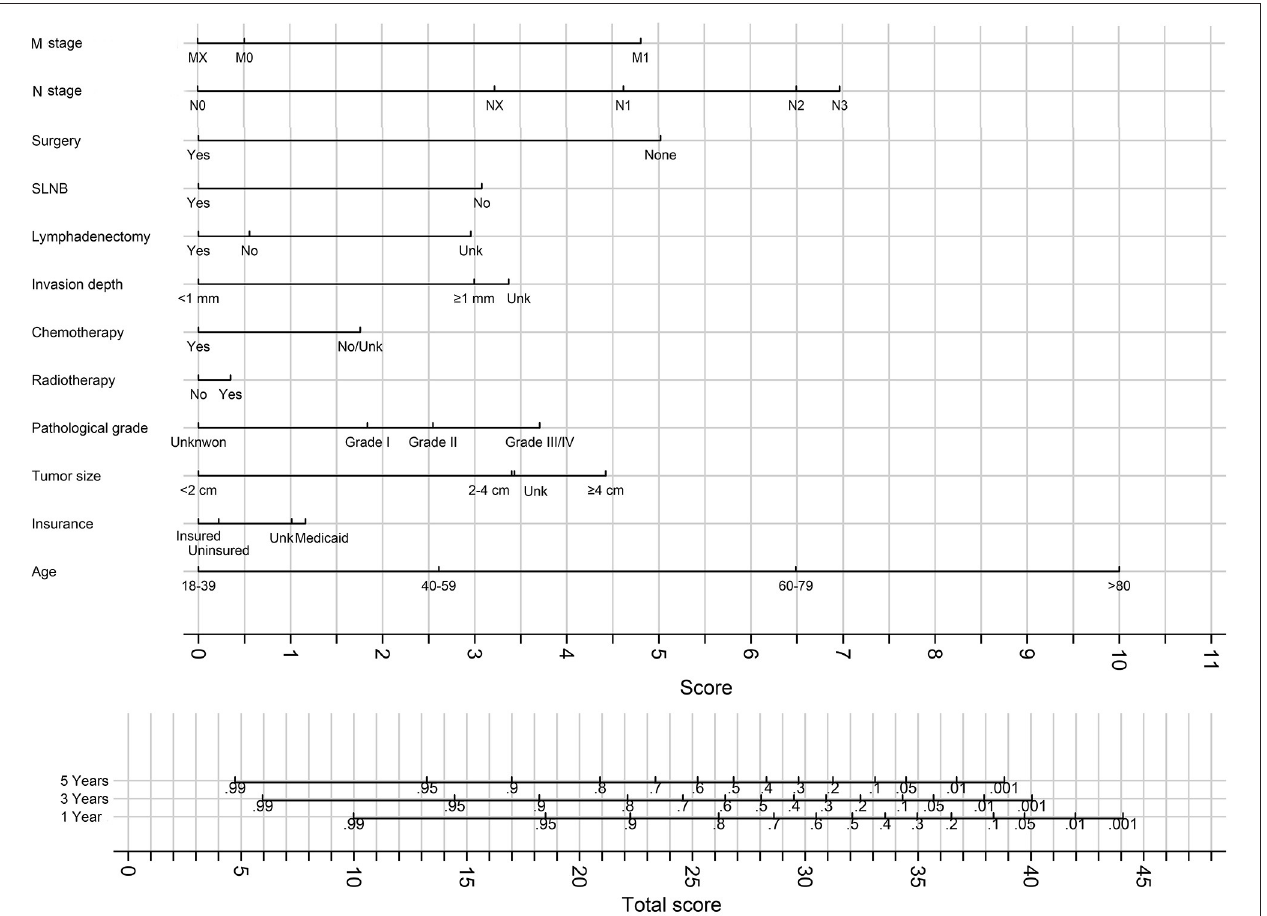
FIGURE 9 | The nomograms for predicting 3- and 5-years CSS. Unk, unknown.